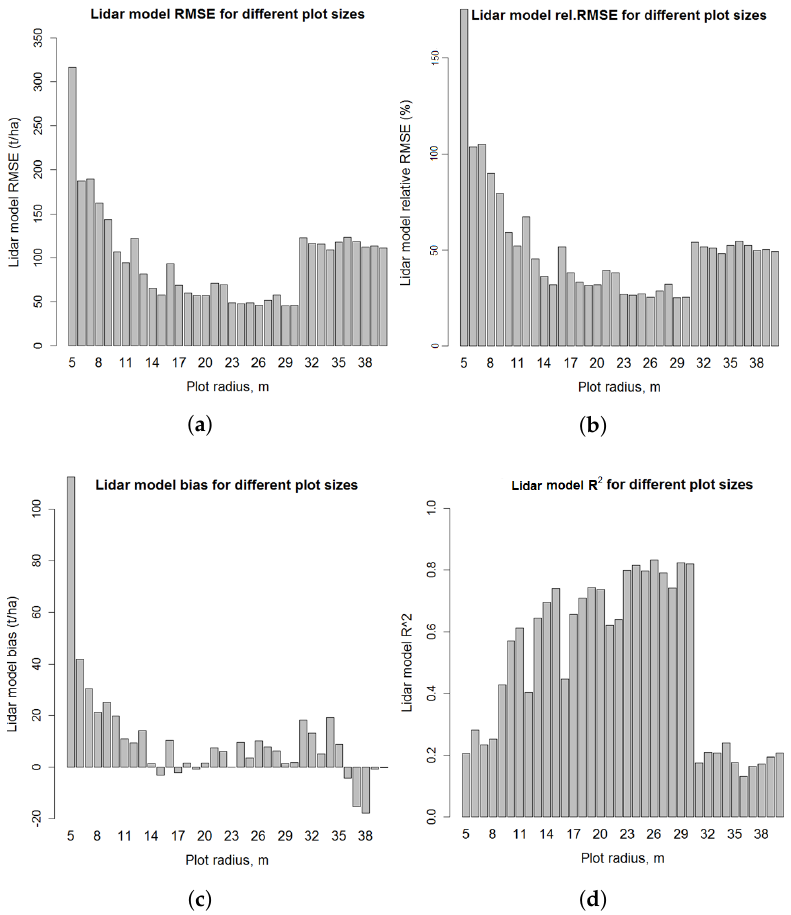
Figure 8. Model statistics for LiDAR model made using varying field plot sizes. Models with radii 5–30 m are based on 46 plots; models with radii 31–40 m are based only on 10 plots: ( a ) Absolute RMSE (t/ha); ( b ) Relative RMSE; ( c ) bias (t/ha); and ( d ) R2 of LiDAR